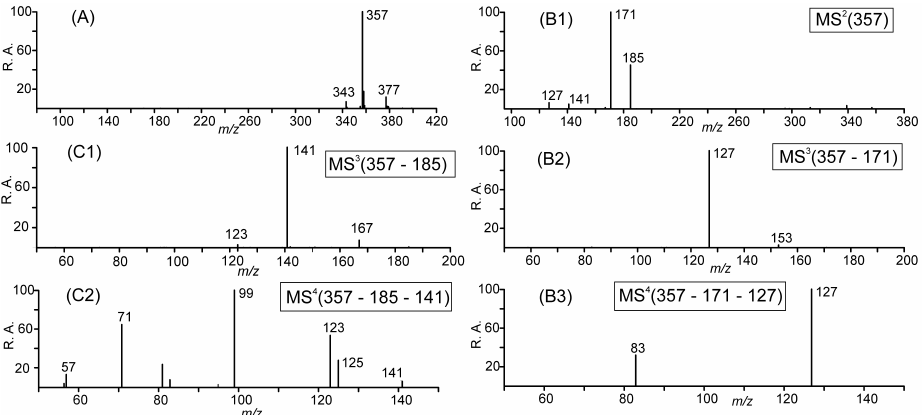
Fig. 5. ( − )ESI-MS data for the relatively abundant MW 358 compound (RT 24.7min; Fig. 1A) present in α -pinene ozonolysis SOA, assigned to a covalent dimer of the ester type: (A) first-order mass spectrum; (B1) m/z 357MS 2 spectrum; (B2) and (B3) m/z 357 → m/z 171MS n ( n = 3 , 4) spectra; and, (C1) and (C2) m/z 357 → m/z 185MS n ( n = 3 , 4) spectra.